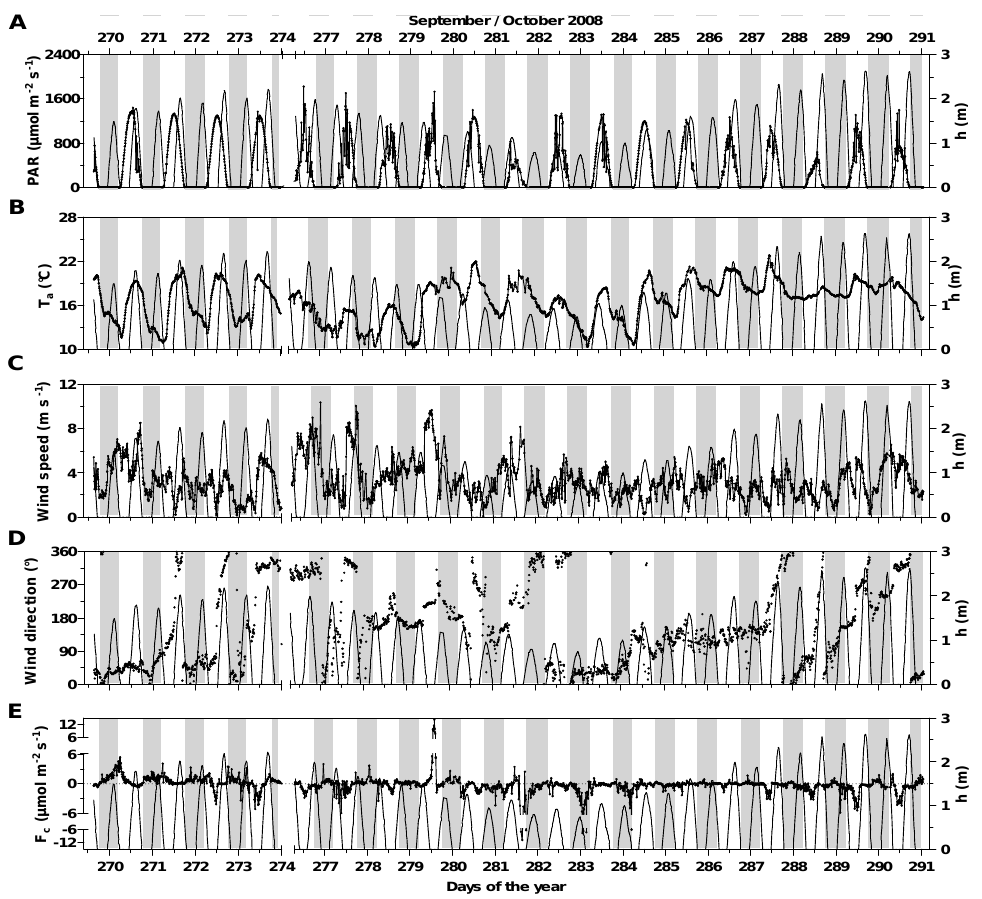
Fig. 5. Environmental parameters and carbon dioxide fluxes measured during the EC deployment in the Arcachon flat (St. 1) from 25 September at 15:10 to 17 October 2008 at 01:10 (GMT). (A) Photosynthetically active radiation PAR (µmolm − 2 s − 1 ) and water height (m); (B) temperature of the air ( ◦ C); (C) wind speed (ms − 1 ) ; (D) wind direction ( ◦ ) and (E) carbon dioxide fluxes (µmolm − 2 s − 1 ) . Negative fluxes represent sinks of CO 2 , and positive fluxes represent sources of CO 2 to the atmosphere by convention. Day 269 squares with 25 September 2008, and grey bands represent night periods. Data between 30 September (00:10) and 2 October 2008 (07:10) could not be measured due to technical problems during the deployment. A PAR threshold of 20µmolm − 2 s − 1 was chosen to separate day and night cases, and low tide cases correspond to zero-water heights. A specific range for F c (E) was chosen for a better visualisation of CO 2 flux